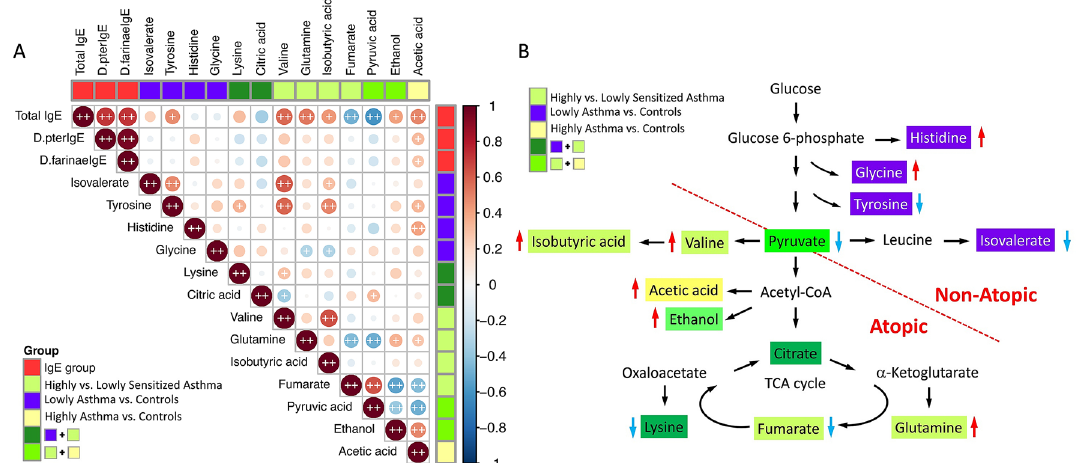
Figure 1. Heatmap of Spearman’s rank correlation coefficients between metabolites associated with lowly and highly sensitized asthma ( A ) and metabolic pathways of metabolites associated with atopic and non-atopic asthma ( B ). Red color represents positive correlations; blue color represents negative correlations; red arrow represents increase; blue arrow represents decrease. + symbol means a P -value < 0.05; ++ symbol means a P -value <